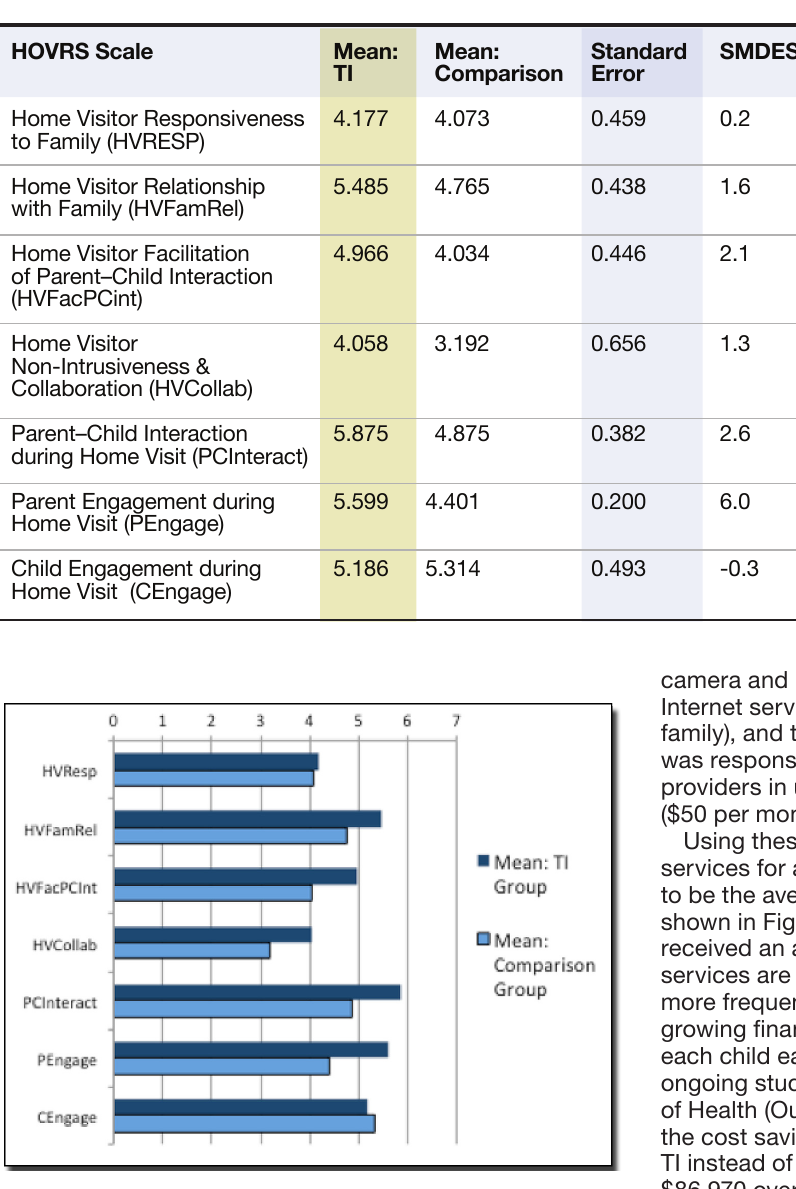
Figure 2. HOVRS differences between TI and comparison